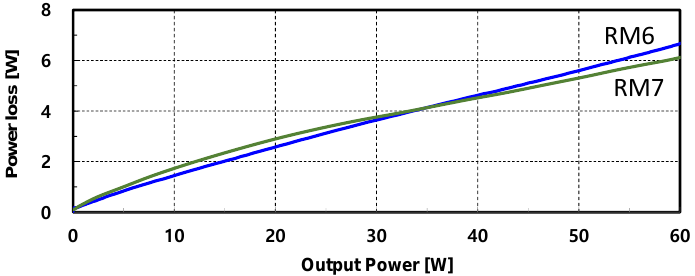
Figure 23. Characteristics of internal power dissipation versus load current of a QR flyback converter with SDAS at an input voltage of 310 V.